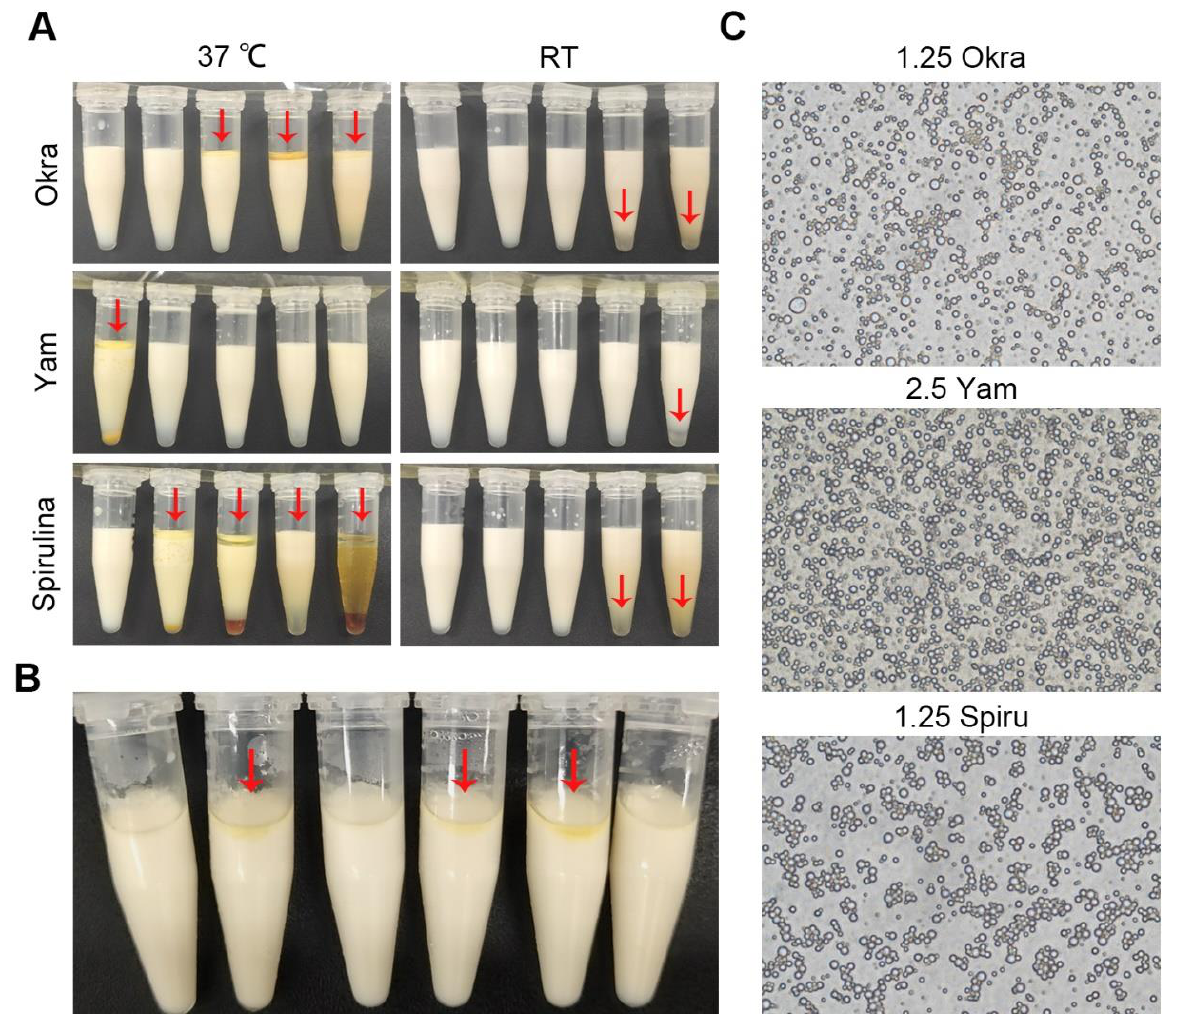
Figure 1. Stability study and morphology. ( A ) The 21-day storage stability. From left to right: 1.25, 2.5, 5, 10, and 20 mg/mL. Emulsions were stored at 37 °C and at room temperature for 21 days. ( B ) Forced thermal stability study. From left to right: 1.25 and 2.5 mg/mL okra polysaccharide, 2.5, 5, and 10 mg/mL yam polysaccharide, and 1.25 mg/mL spirulina polysaccharide emulsions. Here, the stratification of the emulsions at 85 ◦ C over 2 h is shown. ( C ) An optical microscope was employed to observe the morphologies of the emulsions of 1.25 mg/mL okra polysaccharide, 2.5 mg/mL yam polysaccharide, and 1.25 mg/mL spirulina polysaccharide at room